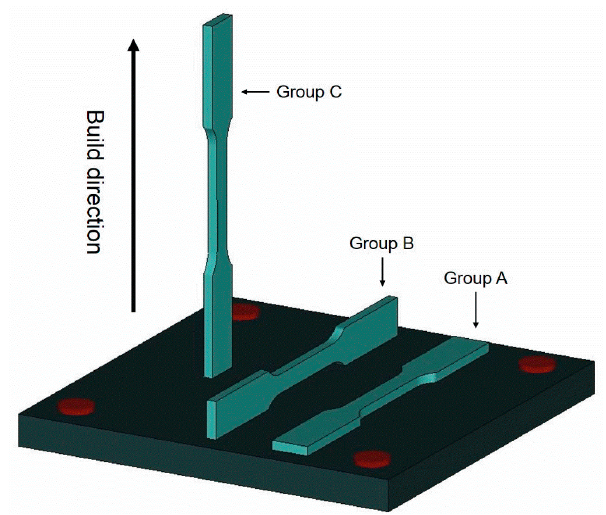
Figure 3. Positions selected for residual stress measurement.